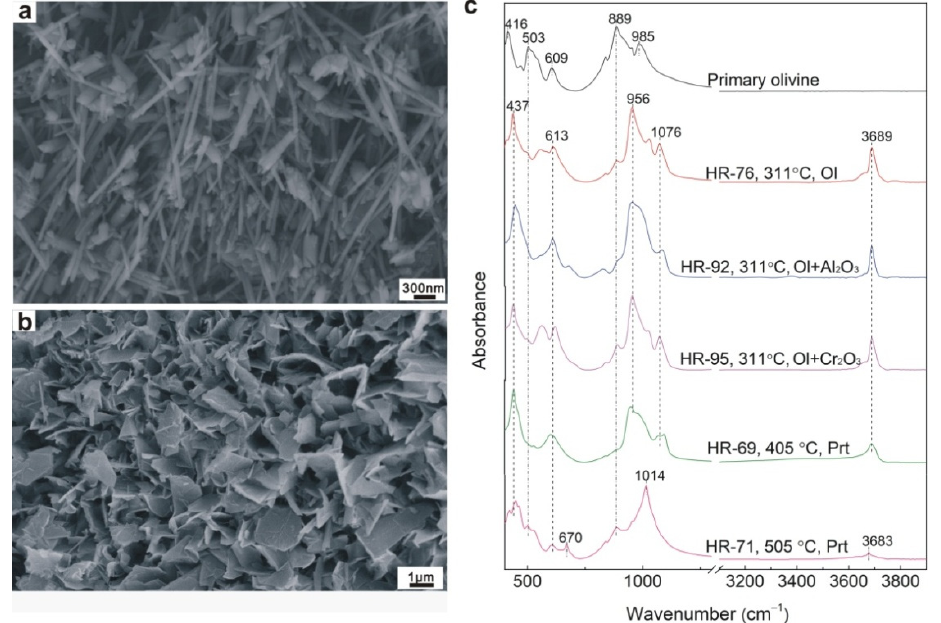
Figure 2. Identification of secondary hydrous minerals with scanning electron microscope imaging ( a , b ) and FTIR analyses ( c ).